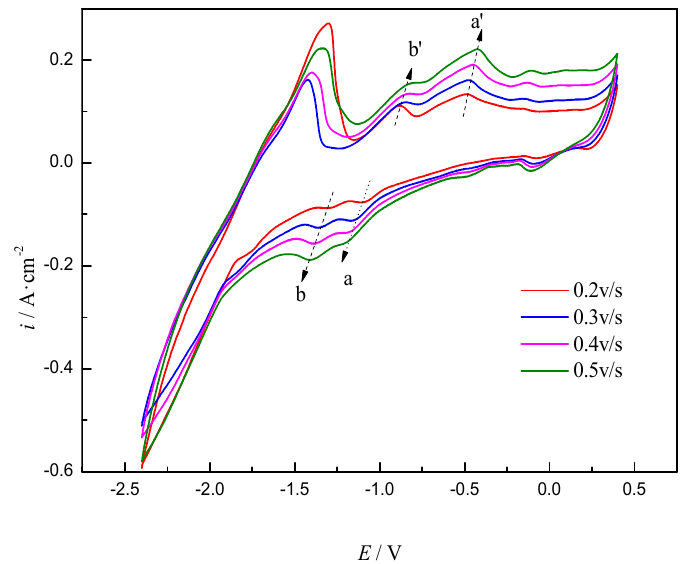
Figure 6. Cyclic voltammetry curve at different sweep speeds of Pt electrode after adding 2 g of LiMn 2 O 4 to NaCl-CaCl 2 molten salt.